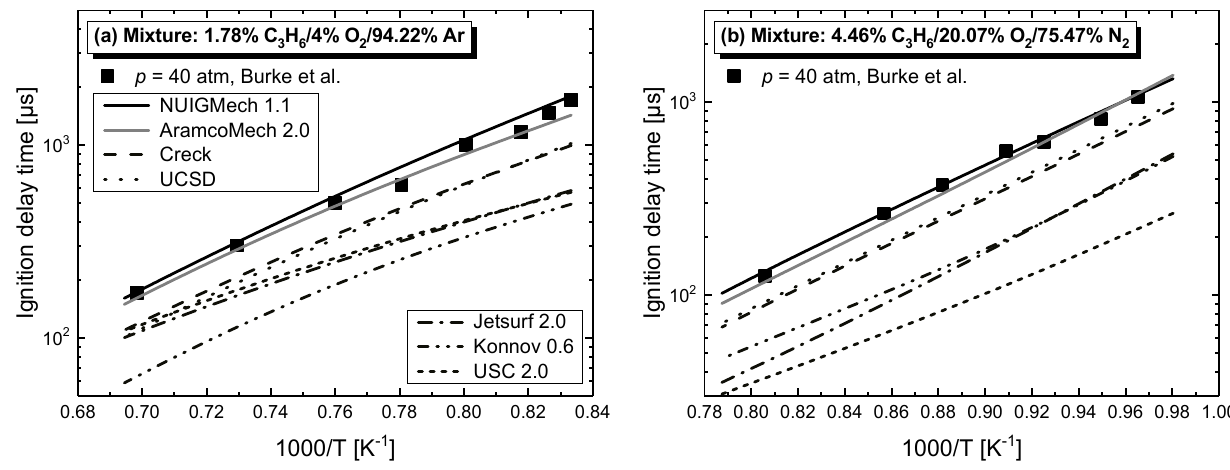
Figure 8. Comparison of measured and simulated IDTs of propene with RCM for fuel in argon mixture ( a ) and fuel in air mixture ( b ). Symbols: experiments from Burke [39], lines: model simulations.